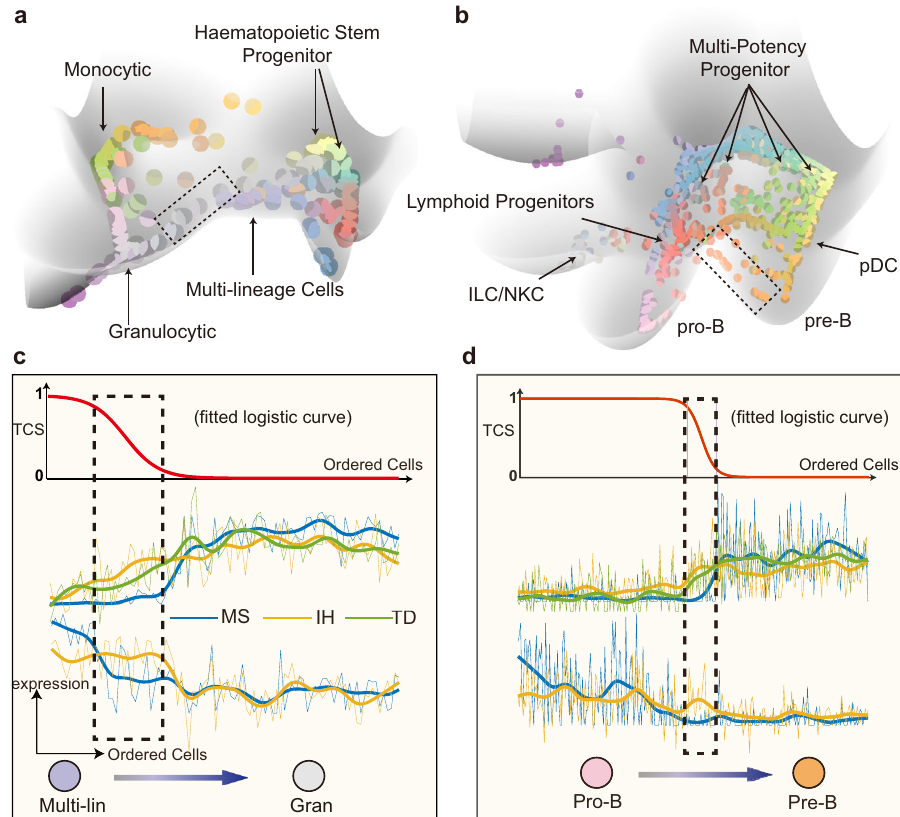
Fig. 5 MuTrans can reveal the underlying complex dynamics in single-cell blood differentiation datasets. a , b The constructed dynamical manifold by MuTrans is shown for the two datasets. The color of each individual cell in dynamical manifold is based on its soft-clustering membership value. In mouse blood cells dataset ( a ), MuTrans highlights the multi-lineage cells in a shallow pit on dynamical manifold. In the blood cells dataset toward lymphoid lineages ( b ), MuTrans discovers plenty of transition cells exist between stable Pro-B and Pre-B cell attractors (marked by dashed squares). pDC: plasmacytoid dendritic cells. ILC: innate lymphoid cells. NKC: natural-killer cells. The complete cell type annotations are shown in Supplementary Fig. 12. c , d The TCS (transition cell score) of transition and average gene expression of the top 5 TD (transition-driver, green), MS (meta-stable, blue) and IH (intermediate-hybrid, yellow) genes for the two interested transition paths marked with dash in ( a , b ). Transition cells are marked by dashed squares. The thin lines represent the raw normalized expression value and thick lines denote the smoothed data. The complete gene lists are shown in Supplementary Table 6 – 8. Multi-lin: multi-lineage cells. Gran: granulocytic Application to large-scale datasets with complex trajectory . To data, and the one after using the pre-processing module DECLARE. We found DECLARE could reduce the calculation test the scalability of MuTrans, we studied on the single-cell time by one magnitude for this dataset. hematopoietic differentiation data in human bone marrow gen- erated by 10x Chromium platform 41 (Fig. 6a). To make the comparison, we applied MuTrans to both the complete (original)